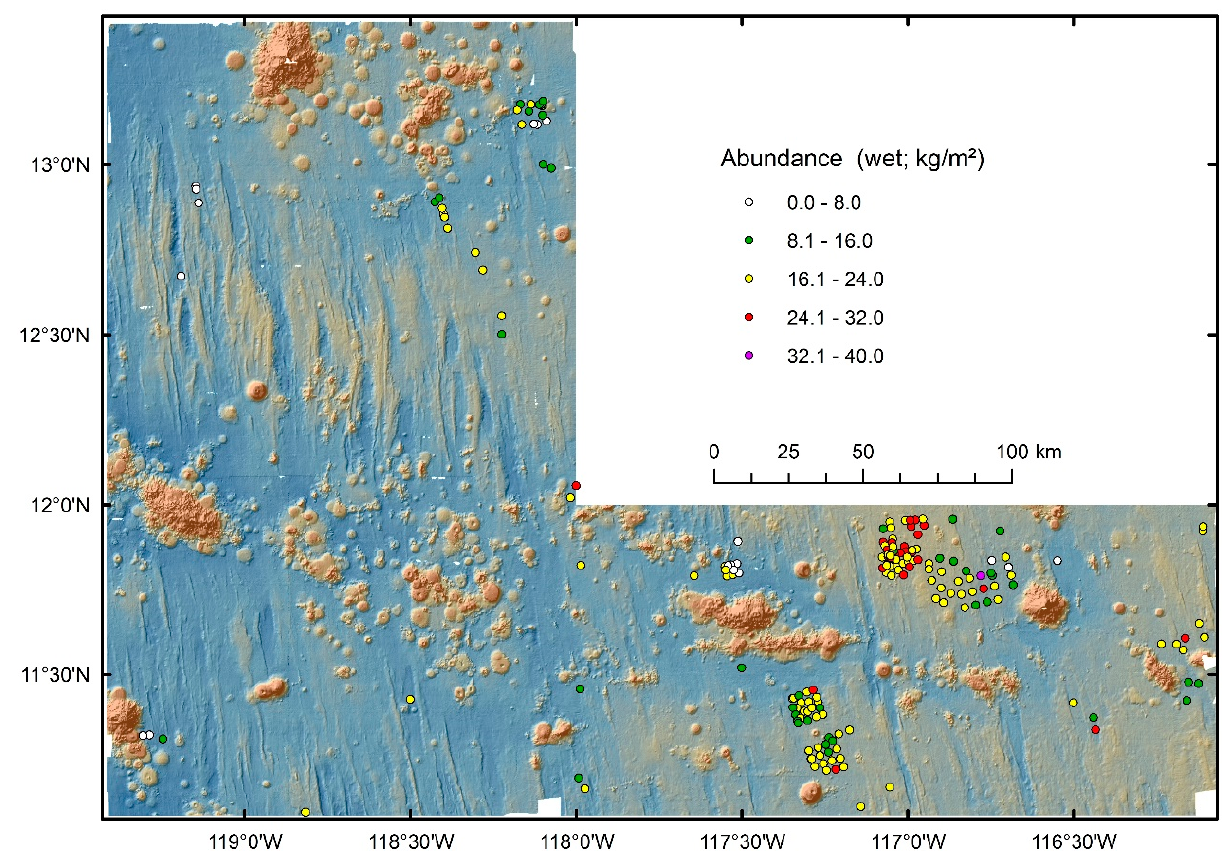
Figure 3. Distribution of nodule abundance used as training data in Area E1.